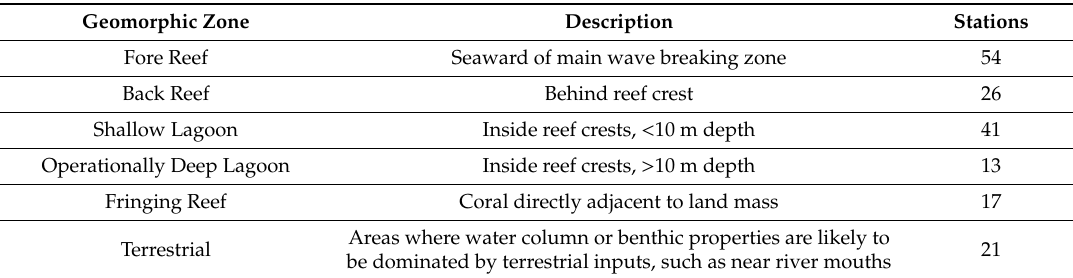
Table 3. Distribution of high-quality stations collected for the six geomorphic zones and the subsequent grouping into three broader categories.